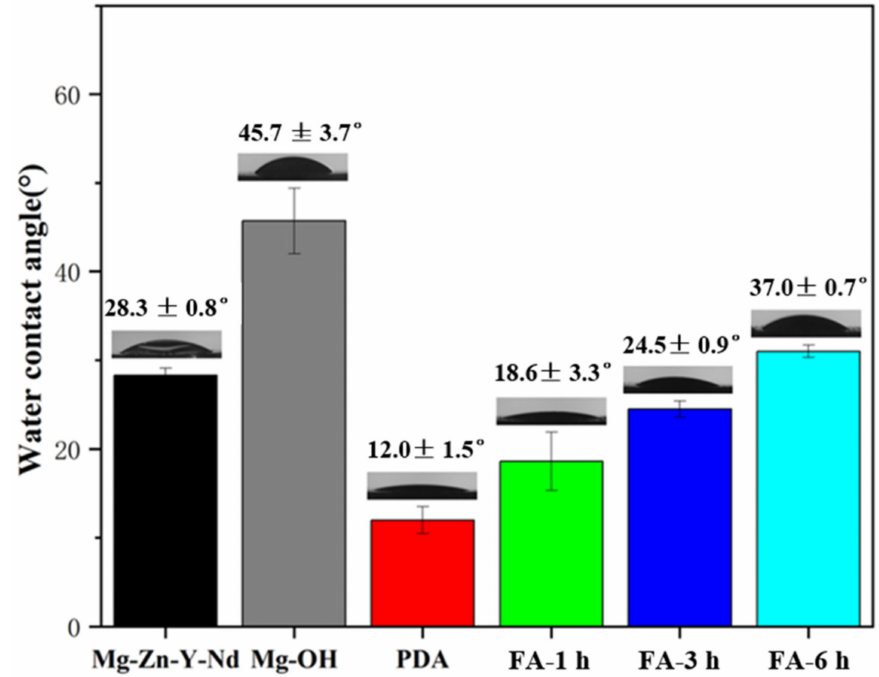
Figure 6. Water contact angle of samples (mean ± SD, n = 6).